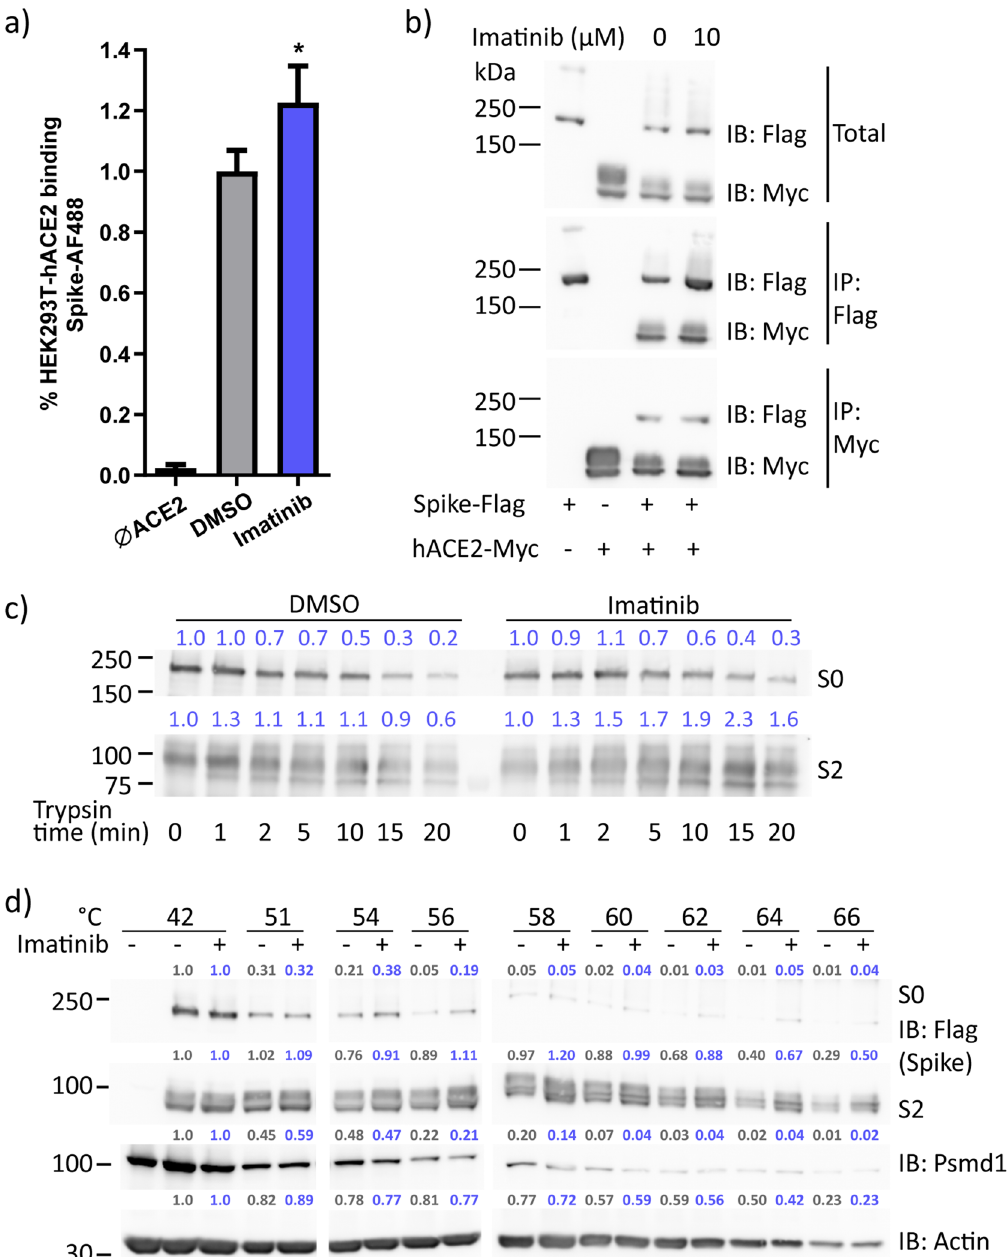
Figure 5. Imatinib affected Spike conformation via direct binding. ( a ) Imatinib increased the localization of Spike on cell surface. Spike-AF488 was added to HEK293T-hACE2 with or without 20 µM imatinib and incubated for 30 min on ice following 5 min in RT. The number of cells labeled with Spike-AF488 was quantified using flow cytometry. The data were analyzed by student t-test; * p ≤ 0.05. ( b ) Imatinib did not change Spike-hACE2 interaction. HEK293T were transfected with hACE2-Myc or Spike-Flag each alone or together and extracts were subjected to immunoprecipitation using the indicated antibodies. The immunoprecipitated proteins were analyzed by SDS-PAGE and immunoblotting (WB) using the indicated antibodies. Result represents one of two experiments. ( c ) Imatinib decreased the enzymatic cleavage rate of Spike. Spike-Flag was overexpressed, purified, and treated with either DMSO or 20 µM imatinib for an hour. Trypsin was added to a final concentration of 200 ng/ml and incubation was stopped at different time points by mixing the samples with Laemmli-buffer and boiling for 5 min. SDS-PAGE and WB was performed and position of S0 (unprocessed) and S2 (processed) Spike are indicated. Blue numbers indicate band intensity ratio compared to lane 0 min. Result represents one of three separate experiments. ( d ) Imatinib bound Spike, analysis by CETSA. Intact cells overexpressing Spike-Flag were treated with 20 µM imatinib or DMSO for 3 h, then incubated under increasing temperature (°C) and extracted. The insoluble fractions were removed by centrifugation and the soluble fractions subjected to SDS-PAGE and WB using the indicated antibodies. Actin and proteasomal subunit Psmd1 served as controls. Band intensity was calculated based on the values obtained at 42 °C. The numbers of DMSO and imatinib treatment are shown in gray and blue, respectively. Result represents one of three biological